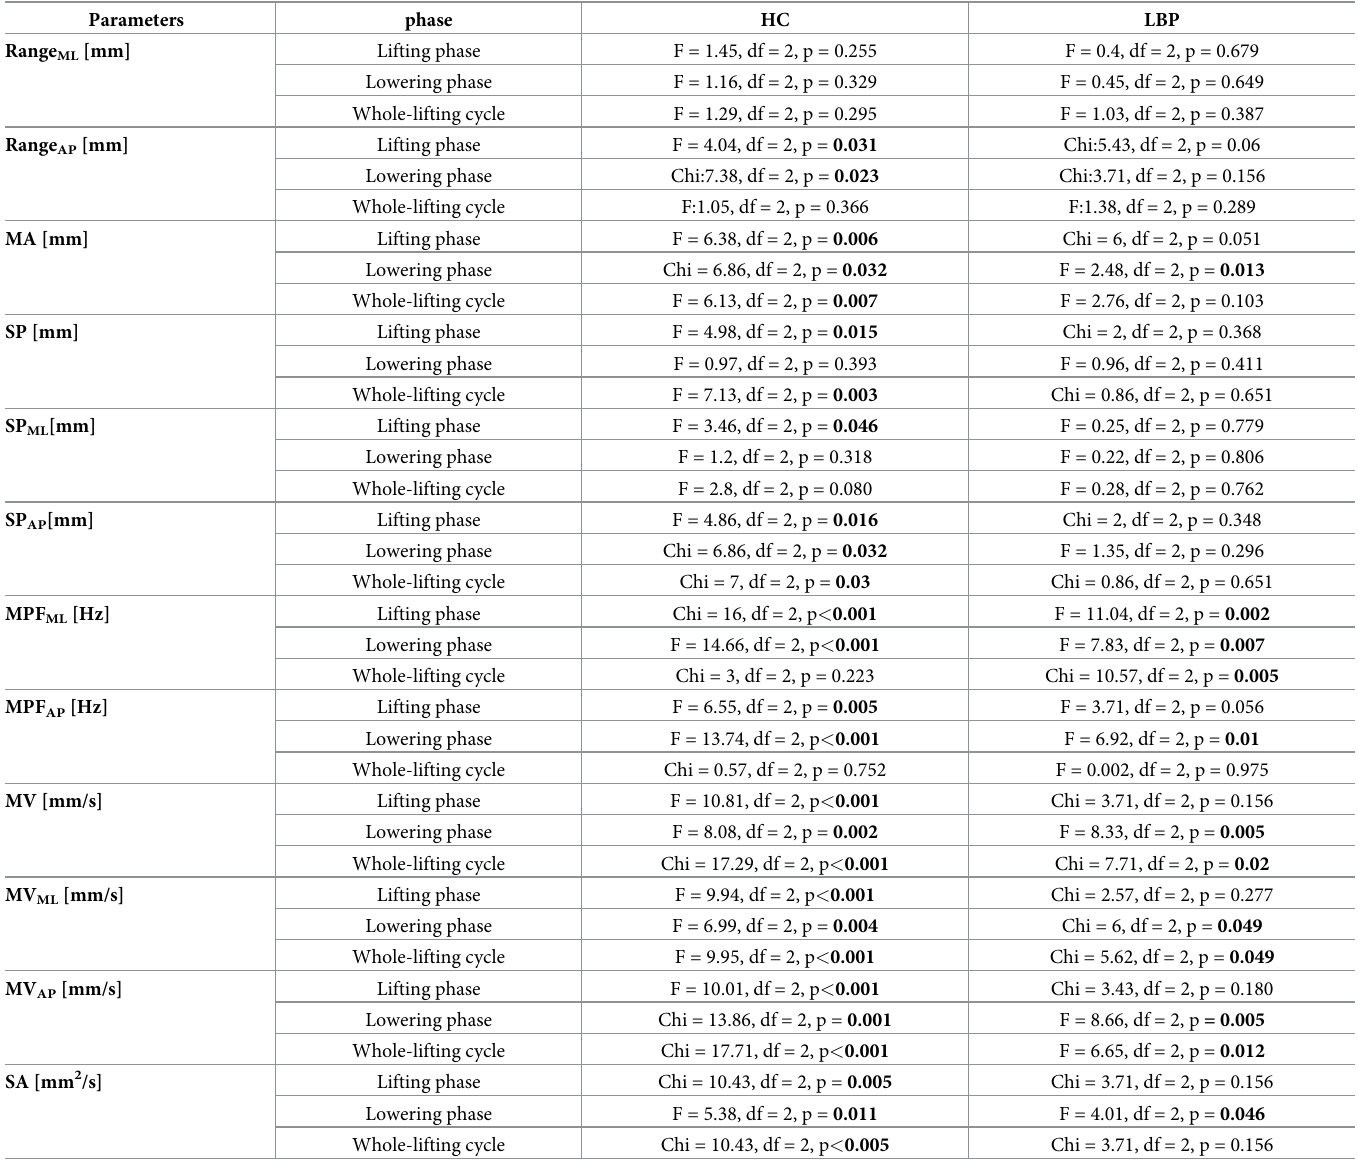
Table 1. Statistical analysis effect of the risk levels on CoP